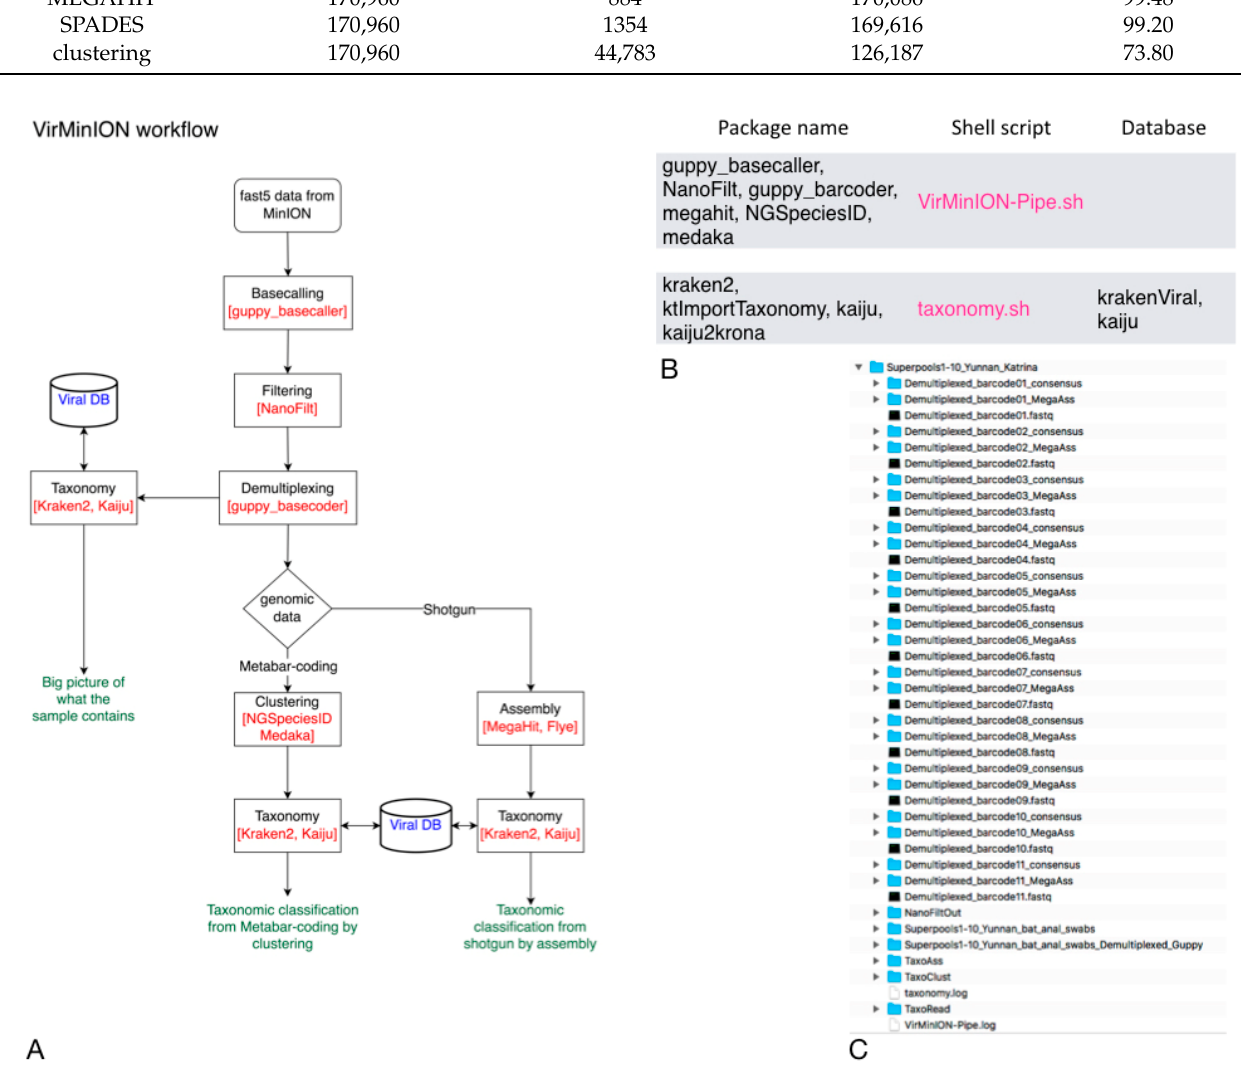
Figure 3. Vir-MinION pipeline. ( A ) Vir-MinION flowchart showing the execution of the three strategies. ( B ) Vir-MinION table showing the scripts, packages and DBs used. ( C ) Vir-MinION data structure at the end of the ALL strategy execution.